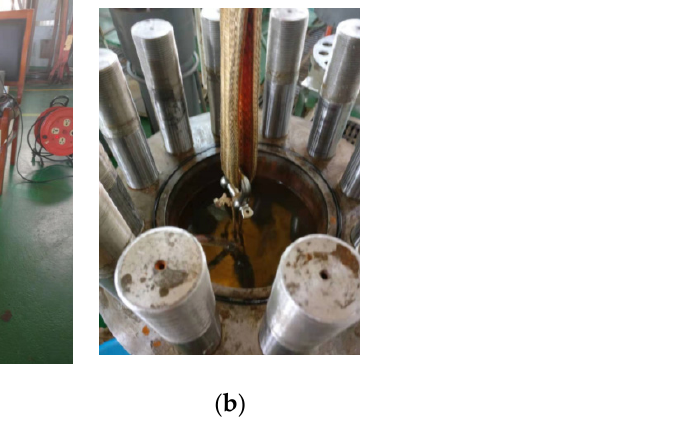
Figure 19. ( a ) Magnetic adhesion test of the electromagnet; ( b ) magnetic adhesion test in the pres- sure chamber.